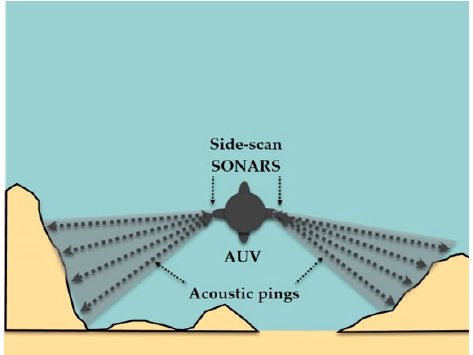
Figure 4. AUV equipped with two side-scan Sound Navigation and Ranging (SONARs).